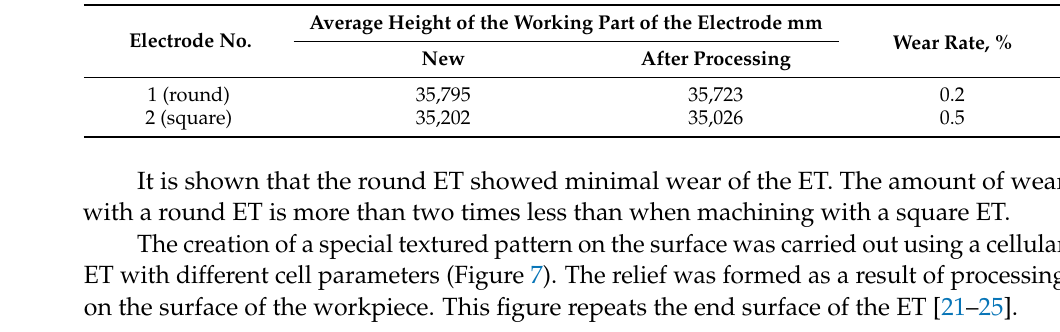
Table 2. The amount of wear of an ET.